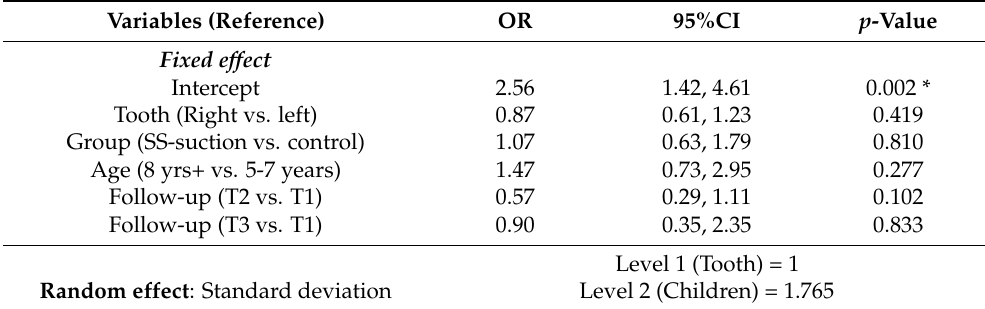
Table 6. Effect of SS-suction on buccal caries controlling for confounding factors: result from multi- level logistic regression (FU